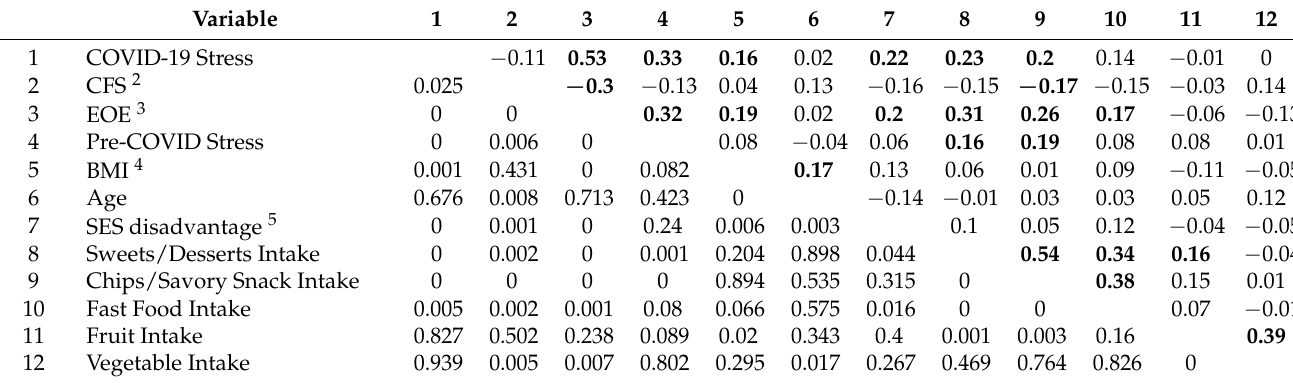
Table 2. Pearson’s correlation of independent variables, covariates, and food intake outcomes ( n = 428) 1 .